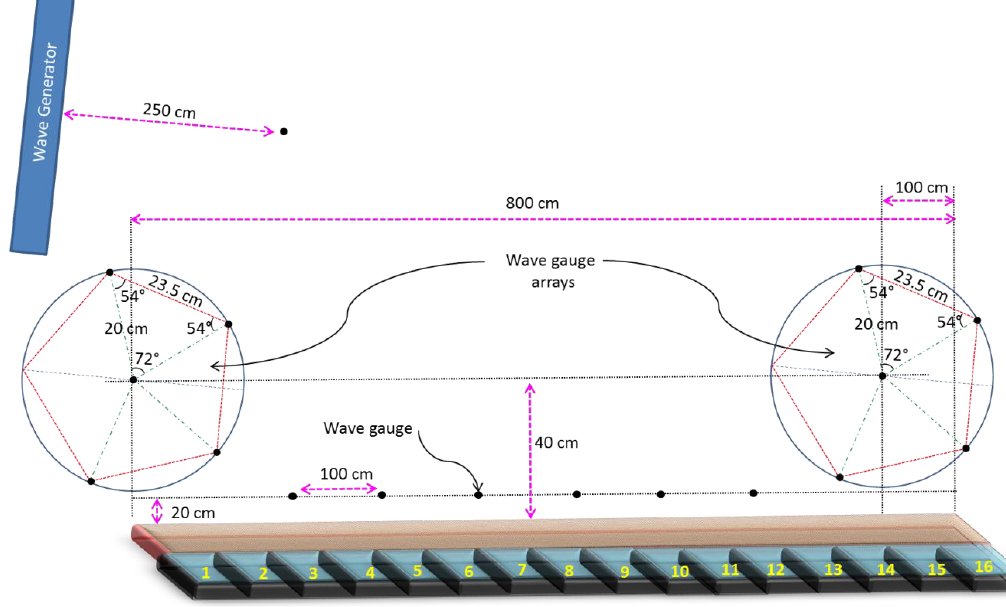
Figure 4. Example of instrument distribution in the basin for the wave angle 80 ◦ (not to scale).